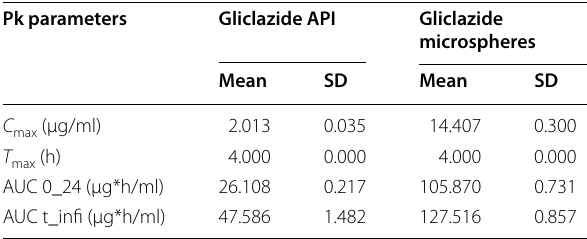
Data are expressed as mean